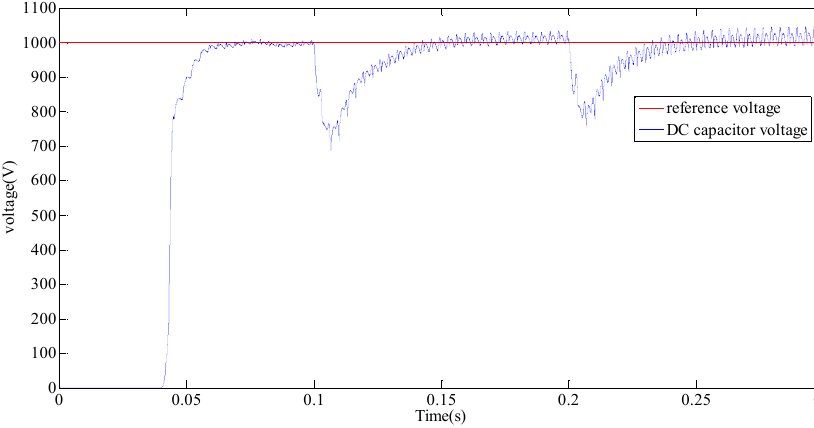
Figure 12. DC capacitor voltage with an increasing load.